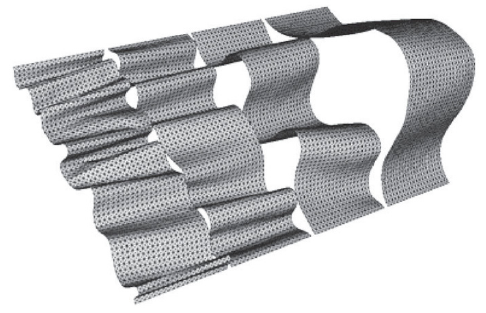
Figure 3. Wrinkling in compression of a woven reinforcement strip with different bending stiffness (from left to right 1, 10, 10 2 , 10 3 N mm − 1 ) [19]. Reprinted from Phil. Trans. R. Soc. A, Vol. 374, Modelling